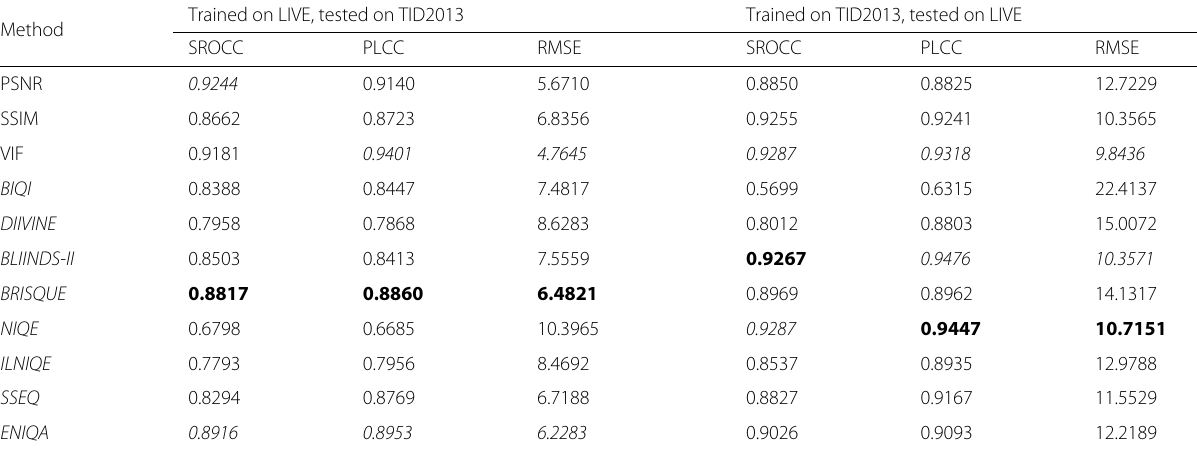
Table 7 Performance indices obtained by training on the LIVE or TID2013 database and testing on the TID2013 or LIVE database Method